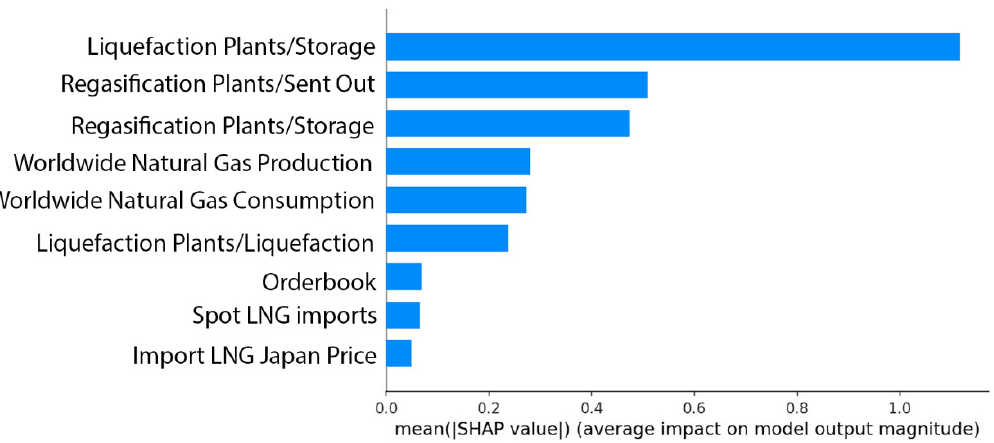
Figure 5. SHAP summary plot for LNG 145K CBM spot rate: 4 months of MLP model.